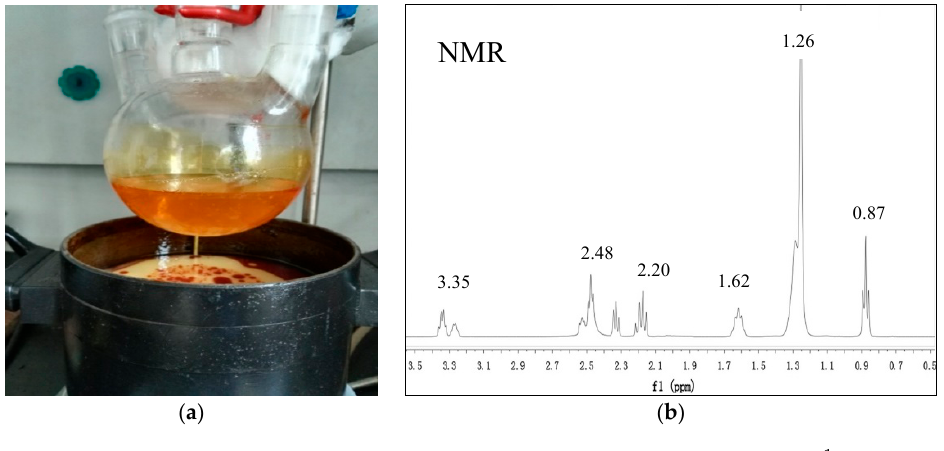
Figure 2. ( a ) Preparation of imidazoline inhibitor; ( b ) Characterization ( 1 H NMR) of imidazoline inhibitor.